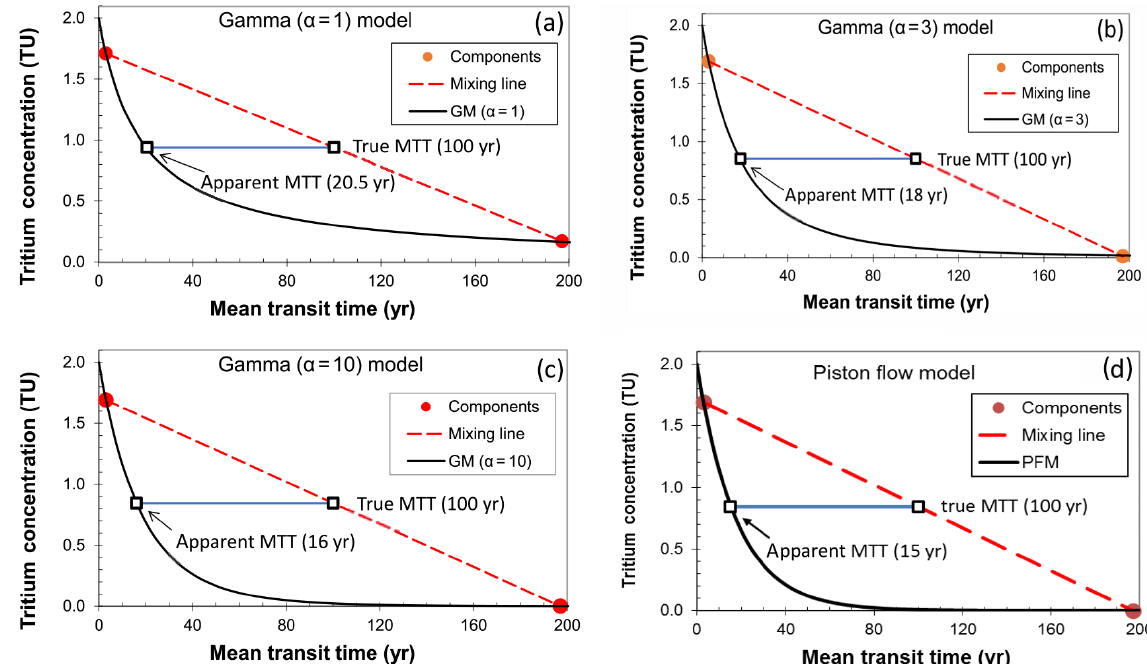
Figure 3. Aggregation errors when the tritium input concentration is assumed to be constant at 2TU. Mean transit times (MTTs) are inferred from tritium concentrations in mixed runoff from two subcatchments with different tritium concentrations and MTTs (shown by red dots) using a range of GMs and the PFM. The relationships between MTTs and tritium concentrations given by the simple models (black curves) are strongly non-linear causing marked differences between the true and apparent MTTs.